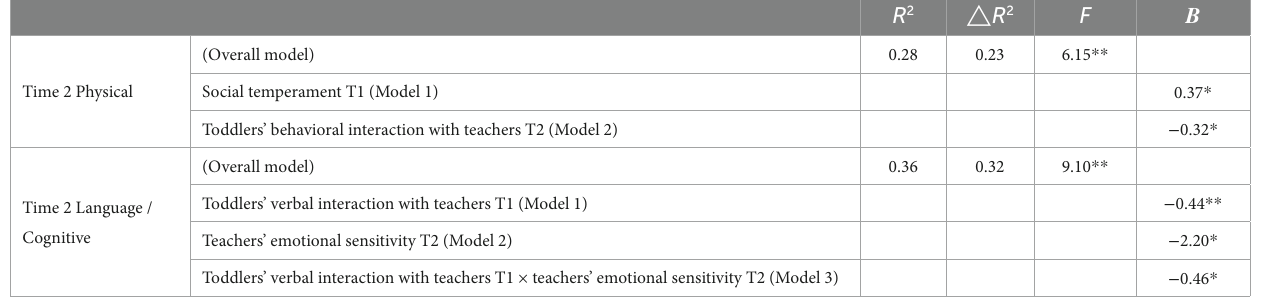
TABLE 6 Regression analysis for study variables predicting toddlers’ development at